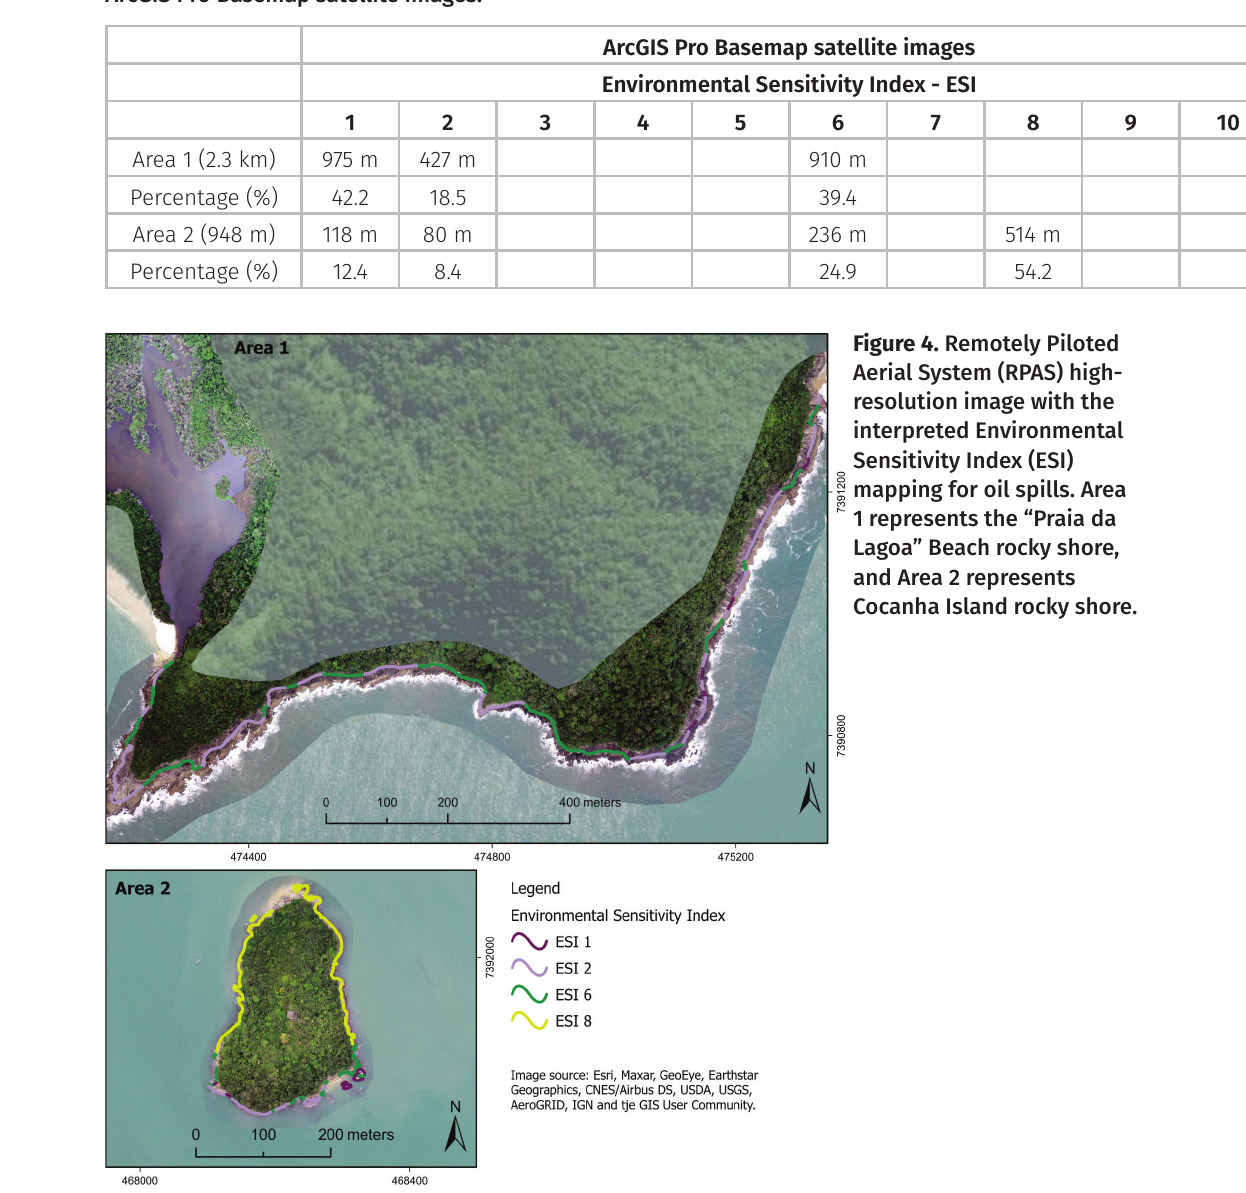
Table VI. Table showing the total extension of each ESI class for Areas 1 and 2 and the corresponding percentage value of these in relation to the total length of the analyzed rocky shores extension. ESI values based on the ArcGIS Pro Basemap satellite images.